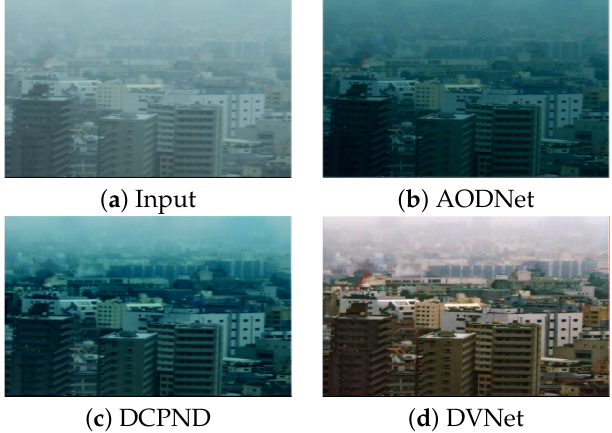
Figure 1. An analysis of limitation of CNN based methods: ( a ) One of real-haze images, ( b ) dehazed result using AODNet, ( c ) dehazed result using DCPDN, and ( d ) dehazed result using our DVNet. Note that the proposed method can restore the most naturally looking image by removing real-haze based on the direct estimation of the radiance